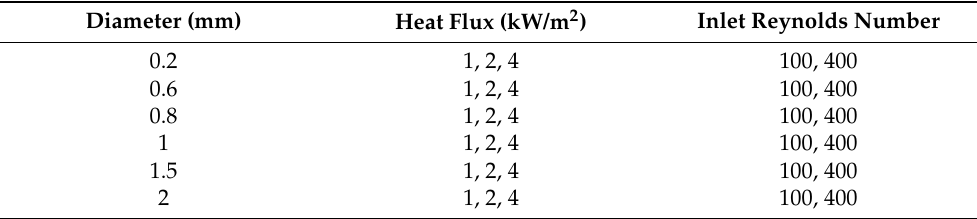
Table 2. Geometric details, inlet, and wall boundary conditions employed in this